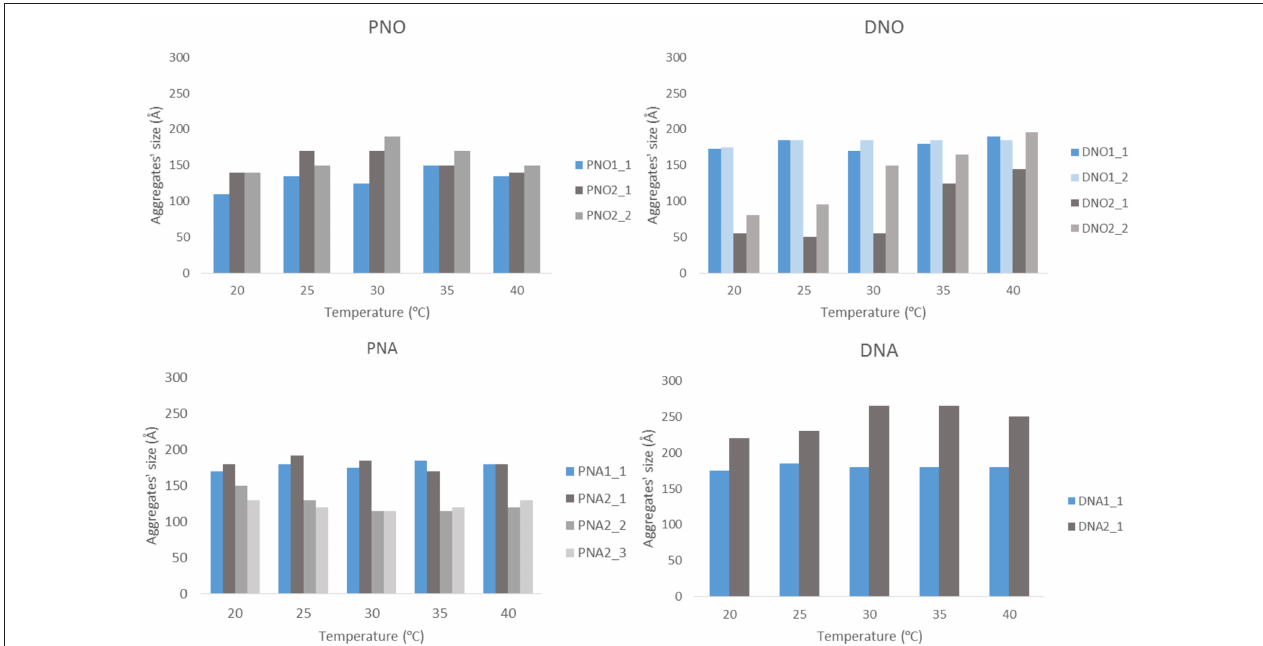
FIGURE 4 | Representation of aggregates’ size vs. temperature. The results are plotted separately depending on the phosphine and the medium. Blue bars stand for XXX_1 and gray bars for XXX_2 samples.